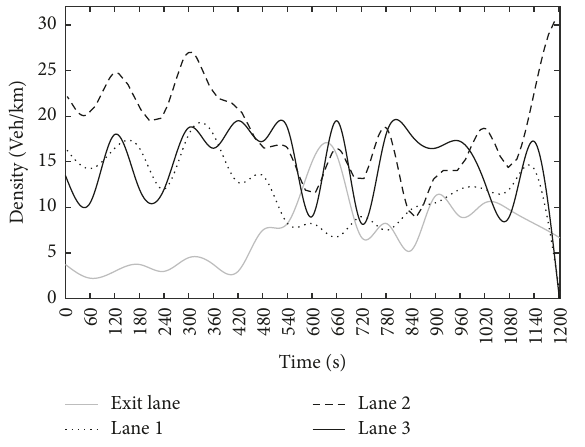
Figure 8: Traffic density diagram.